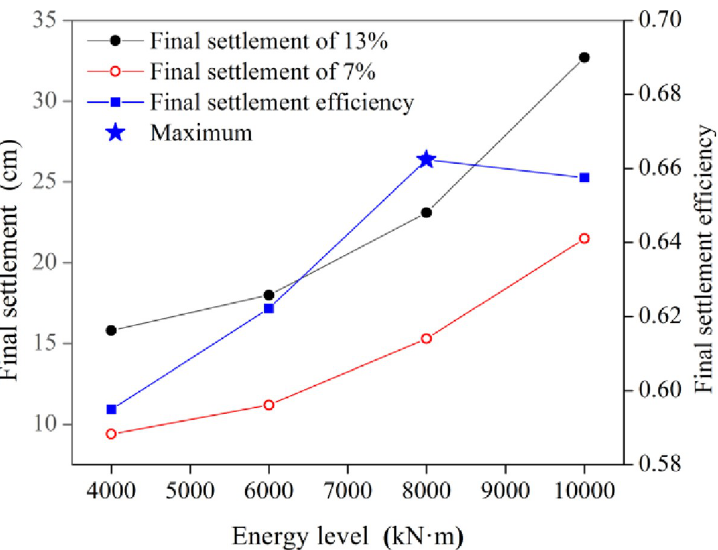
Fig 5. Curves of the final settlement and final settlement efficiency of dynamic compaction verses the energy level.